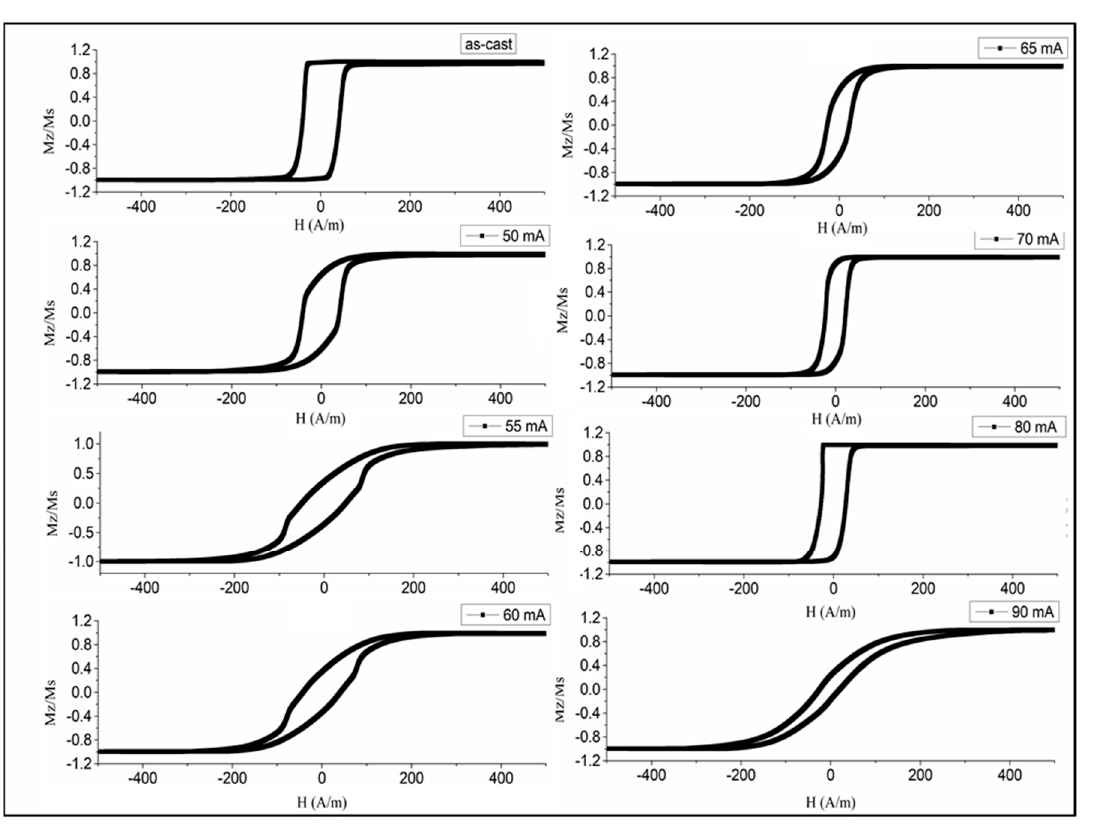
Figure 5. Effect of current intensity during annealing on the hysteresis loops of glass-coated amorphous Co 71 Fe 5 B 11 Si 10 Cr 3 microwires (50 mA corresponds to a current density of 102 A/mm 2 for the wire diameter of 25 microns).